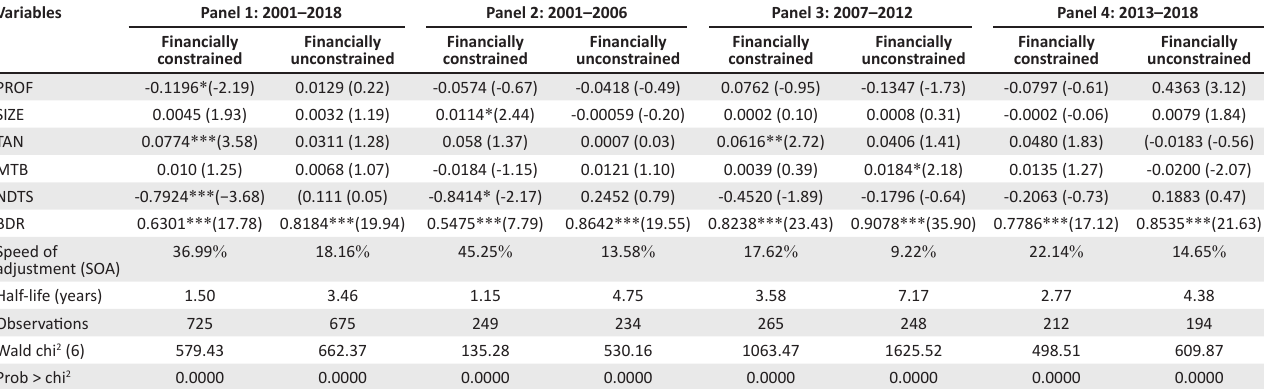
TABLE 5: All panels’ RE tobit estimator regression estimates for empirical model 3 † . Variables